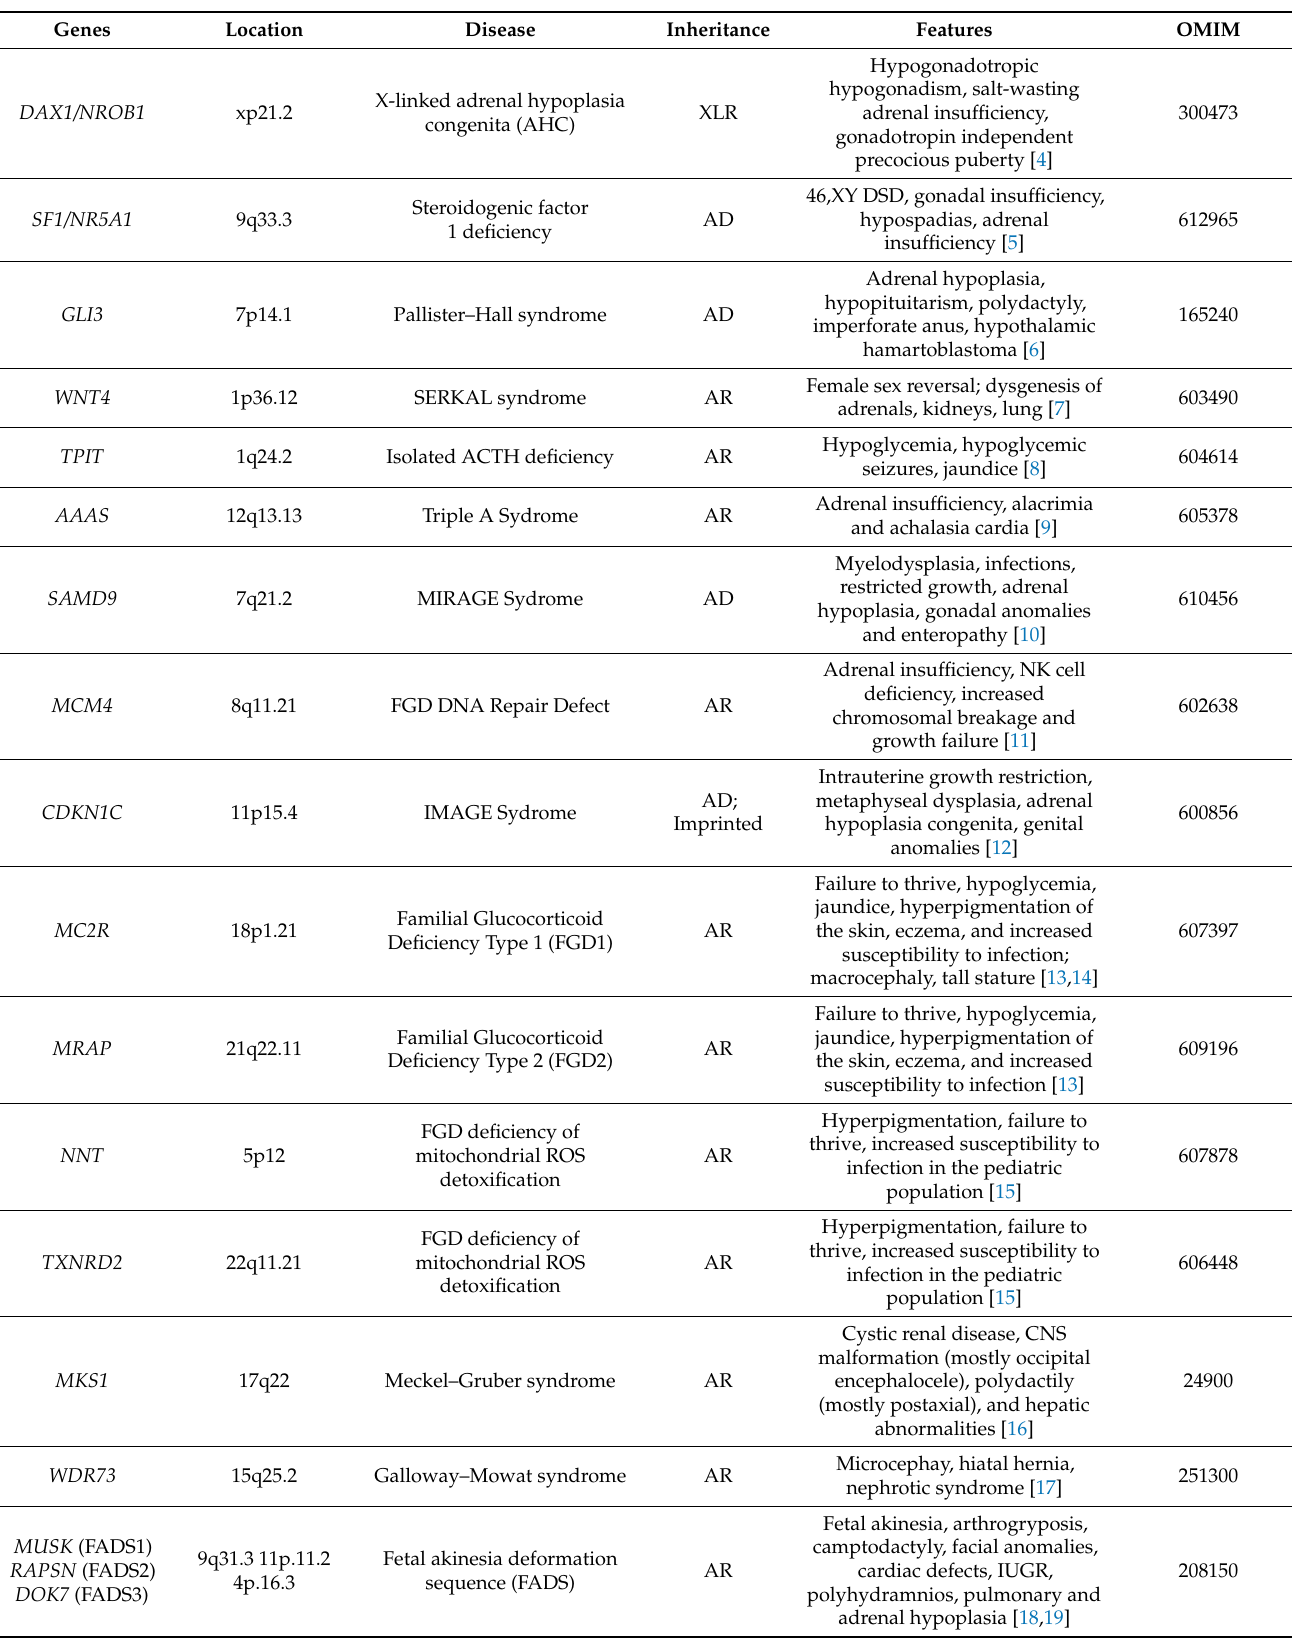
Table 1. Summary of Genes involved in Adrenal Gland Development and Associated